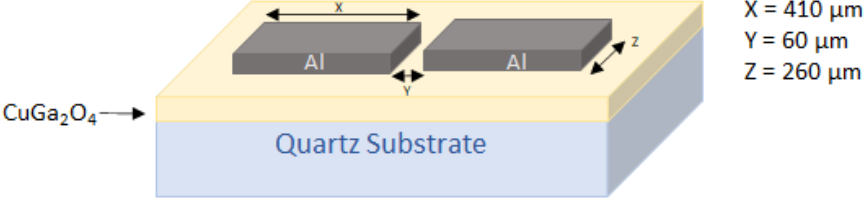
Figure 1. Schematic representation of the configuration used for the electrical measurements.